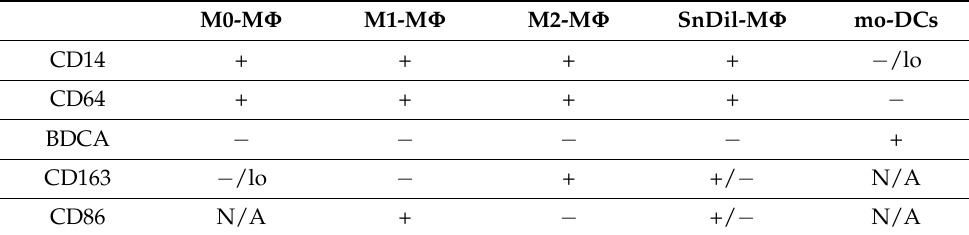
Table 1. Different surface markers in monocyte-derived subpopulations